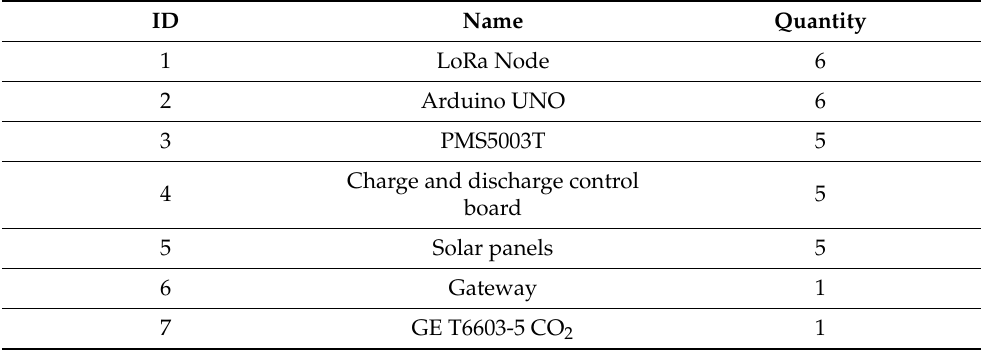
Table 1. Monitoring Station Equipment.